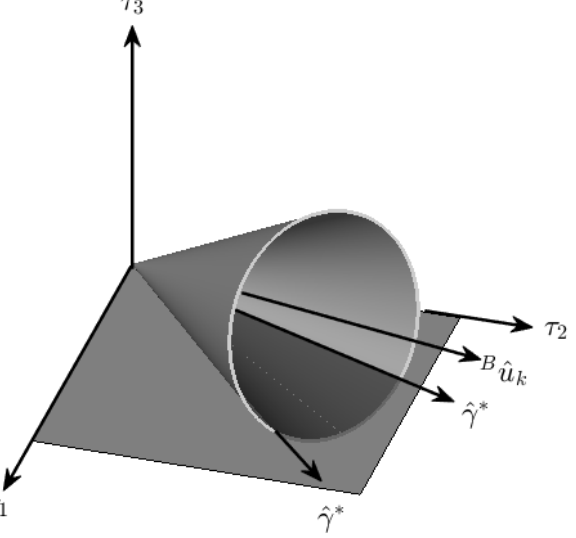
Figure 8. Case 3: the delta-v cone intersects with τ 1 - τ 2 , and the optimal firing directions are along either of the ˆ γ ∗